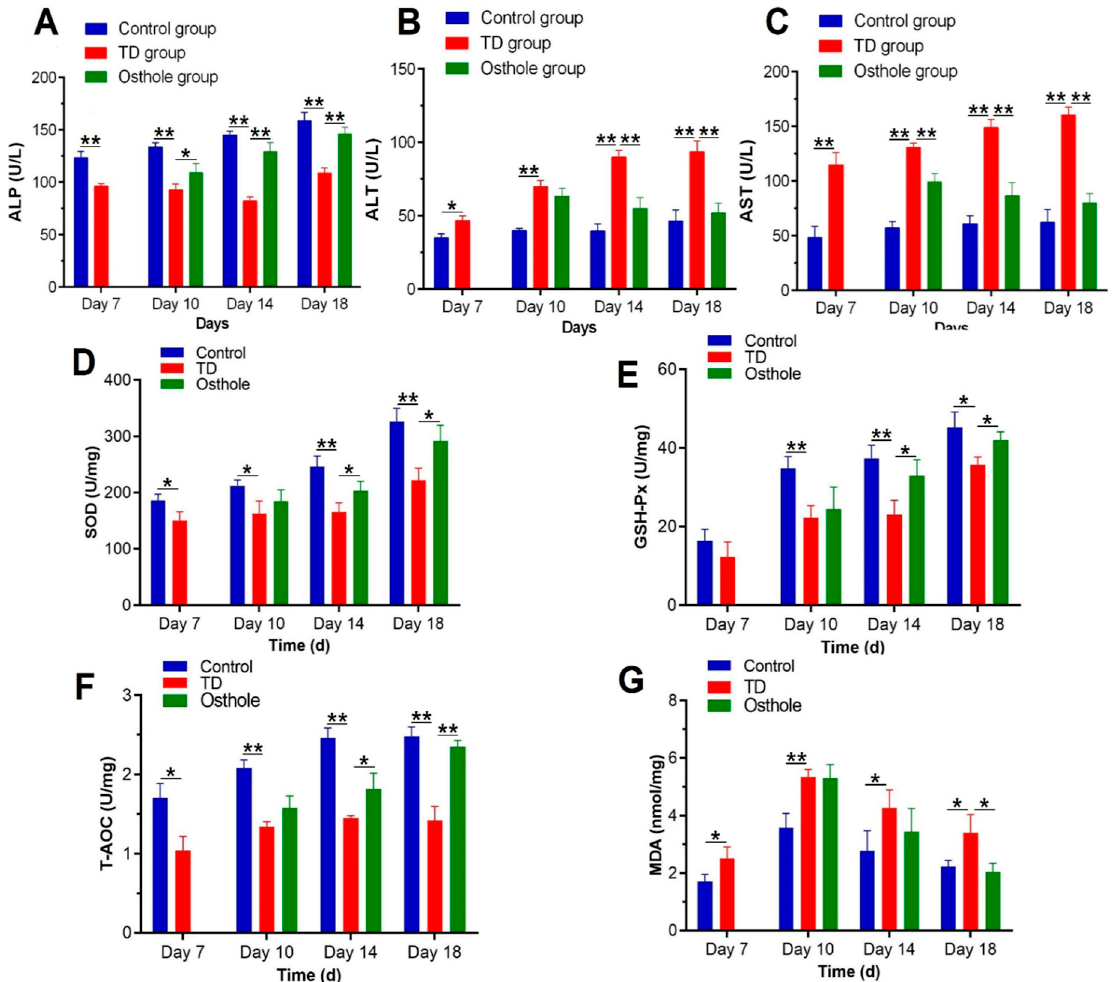
Figure 7. Effect of thiram on serum biochemical and liver antioxidant parameters followed by excellent recovery by osthole in the control, TD, and osthole groups: ( A ) ALP, ( B ) ALT, ( C ) AST, ( D ) GSH-Px, ( F ) T-AOC, and ( G ) MDA. There was a notable di ff erence in values for di ff erent days. The data SOD, ( E ) GSH-Px, ( F ) T-AOC, and ( G ) MDA. There was a notable difference in values for different are expressed as the mean ± SD (* p < days. The data are expressed as the mean ± SD (* p < 0.05).